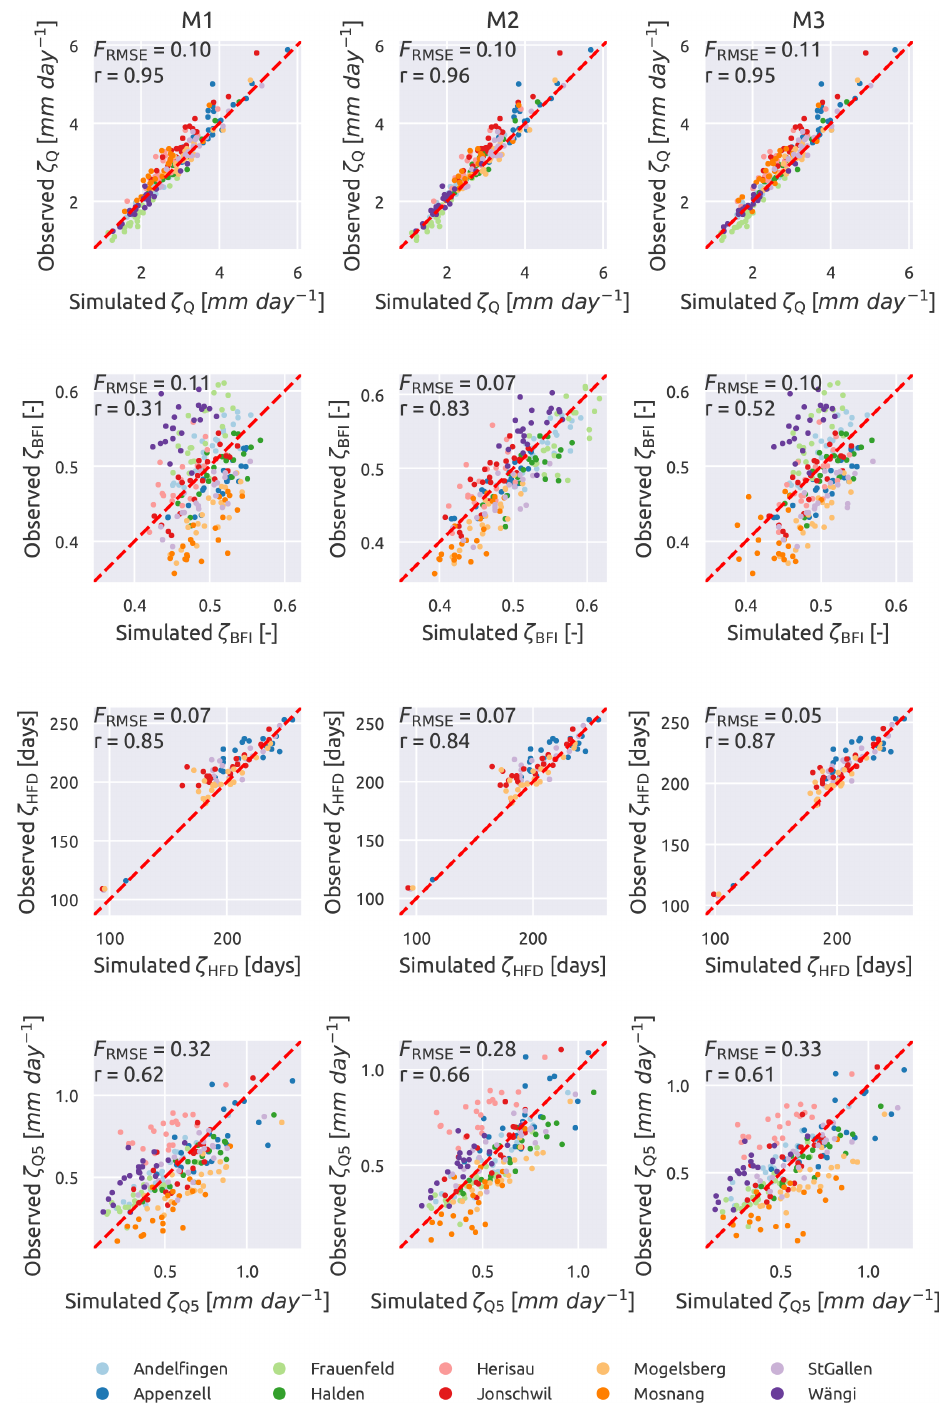
Figure 9. Simulated vs. observed streamflow signatures. Single-HRU model on the left (M1), two-HRU model based on geology in the centre (M2), and two-HRU model based on land use on the right (M3). Each dot represents a year and each colour a subcatchment. From up to bottom, mean daily streamflow ( ζ Q ), baseflow index ( ζ BFI ), mean half streamflow date ( ζ HFD , only the catchment with ψ FS larger than 10%), and 5th percentile of the streamflow ( ζ Q5 ). The red dashed line has a 45 ◦ slope and indicates where all points should align in case of a perfect match. Spearman’s rank score ( r ) is also